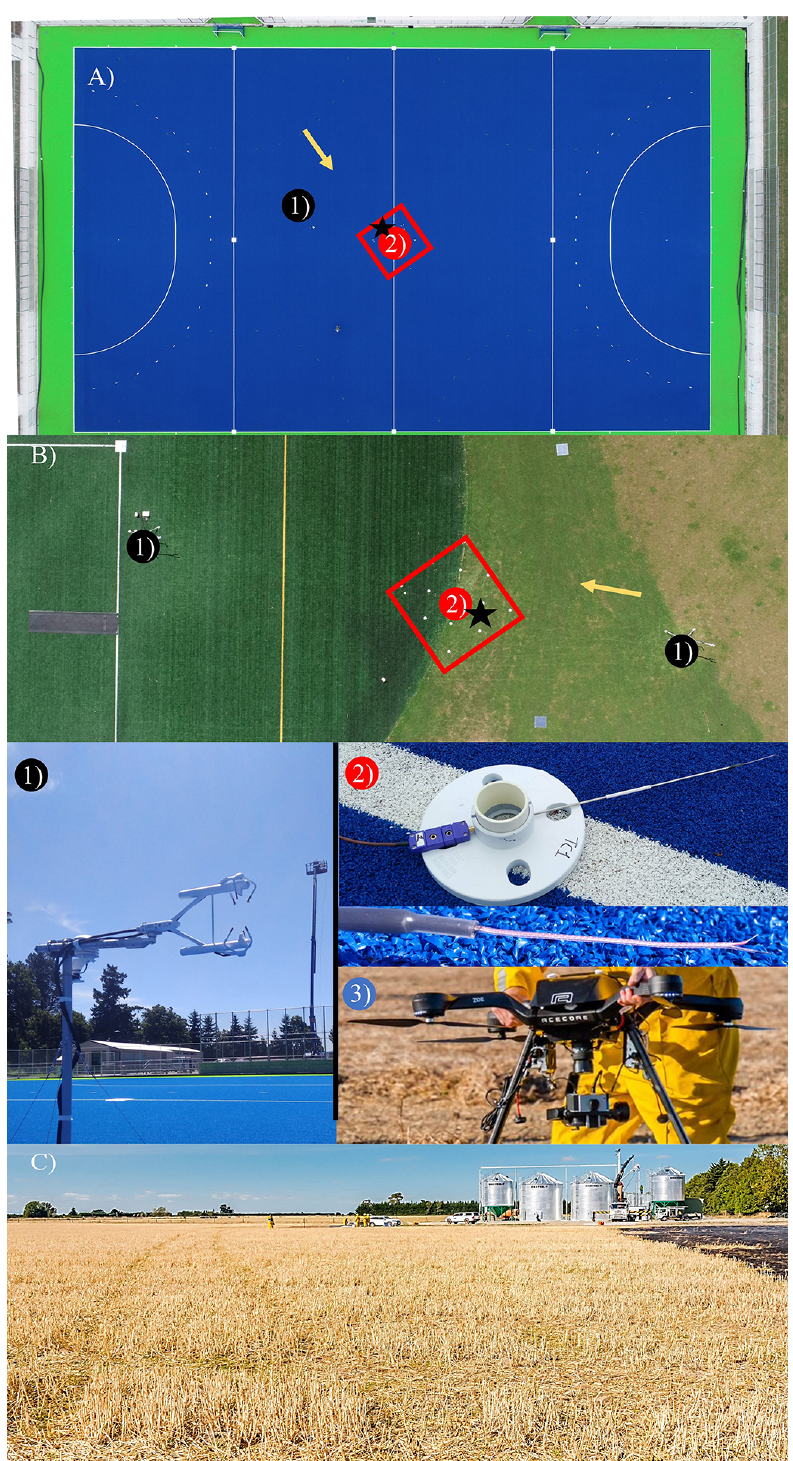
Figure 3. Experiment sites and instrumentation – TURF-T1, TURF-T2, and wheat stubble experiment sites: (a) blue hockey turf, (b) green softball turf with surrounding grass, and (c) a harvested wheat field with stubble. In panels (a) and (b) the positions of sonic anemometer units (black dots, Image 1 – closeup below) and the thermocouple array (red square with red dots, Image 2 – closeup below) are marked. The black star shows the position of the base thermocouple upwind which was used for close surface wind velocity estimation (see Sect. 2.7). The mean wind direction is emphasized by a yellow arrow. Image 3 shows the used quadcopter with a three-axis inertial stabilizer and the Optris camera